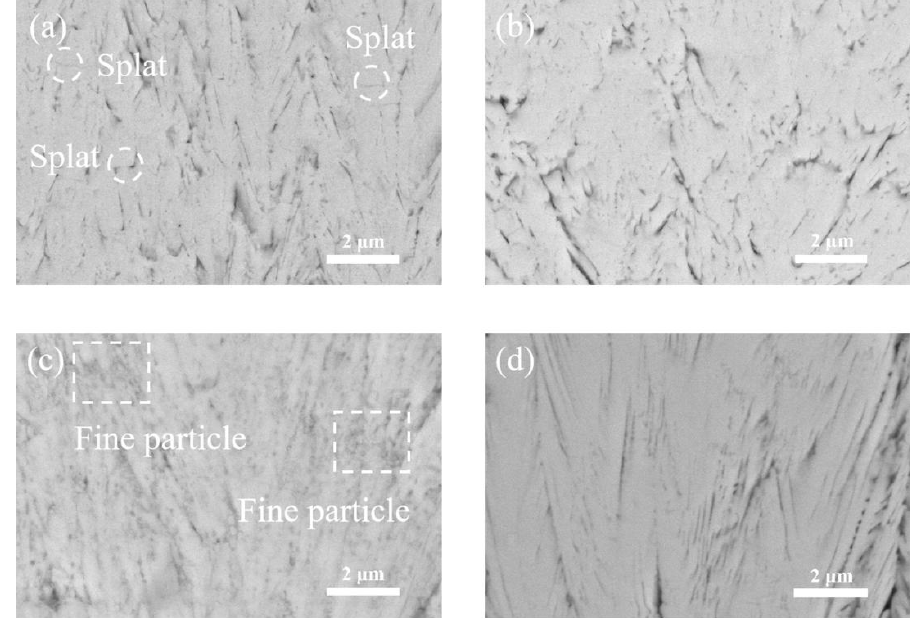
Figure 5. Magnified cross-sectional morphologies of corresponding LC coatings: ( a ) Bottom part of Coating 1, ( b ) column internal part of Coating 1, ( c ) column internal part of Coating 2, ( d ) column internal part of Coating 3.